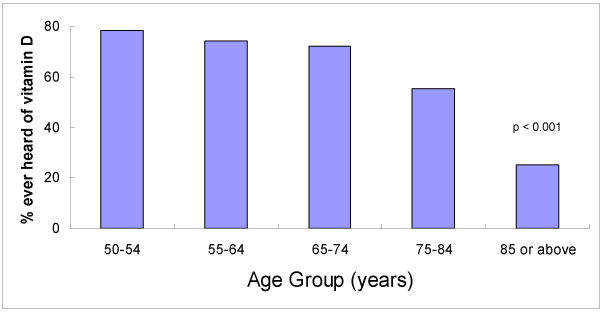
Age stratification of response to the question "Have you heard of vitamin D?".